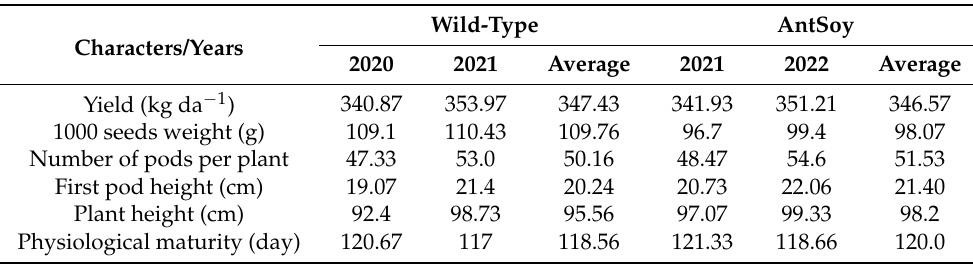
Table 2. The agronomic comparison between the wild type and the mutant for the growing years of 2020 and 2021.